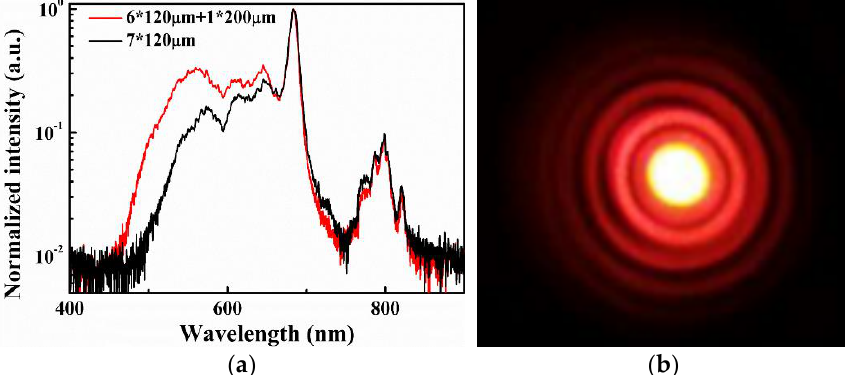
Figure 4. ( a ) SC spectrum after the laser beam propagated through a set of thin plates with mixed thickness. ( b ) The image of output beam